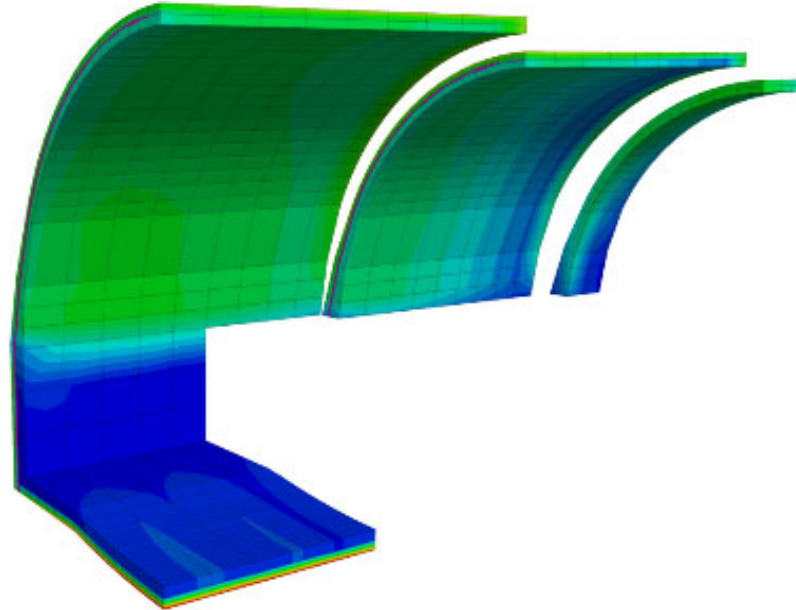
Figure 12. Total displacements in concrete elements. Minimum parameters [12].